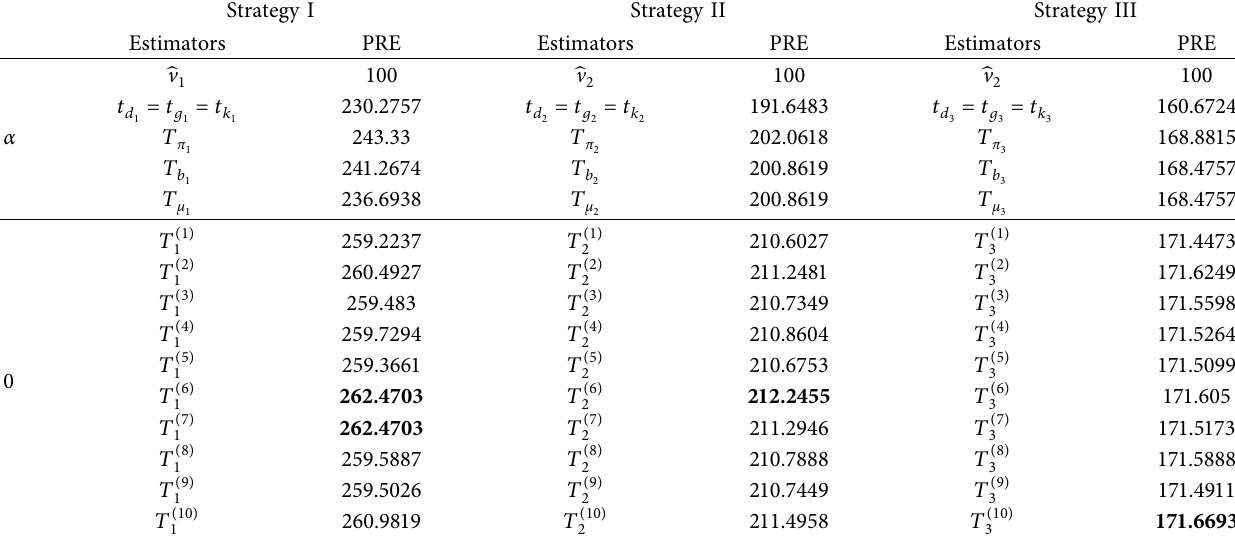
Table 4: PRE of the existing and proposed class of estimators for